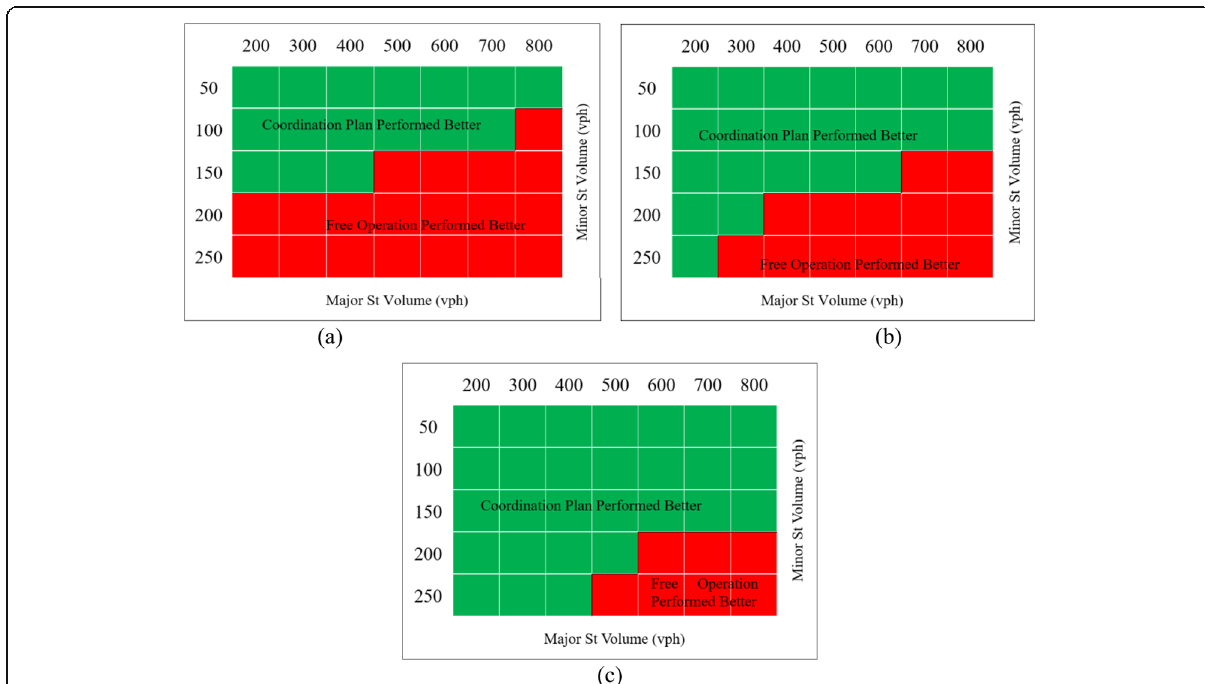
Fig. 5 Performance Comparison between Coordination Plans and Free Operation, a 80-s Coordination Plan; b 100-s Coordination Plan; c 130-s Coordination